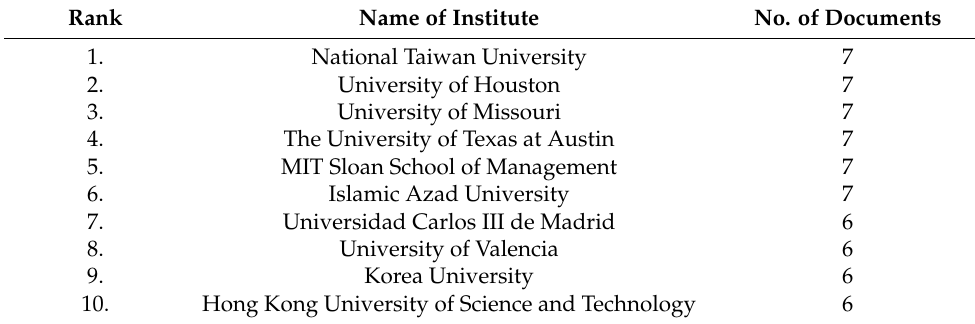
Table 3. Five the most productive